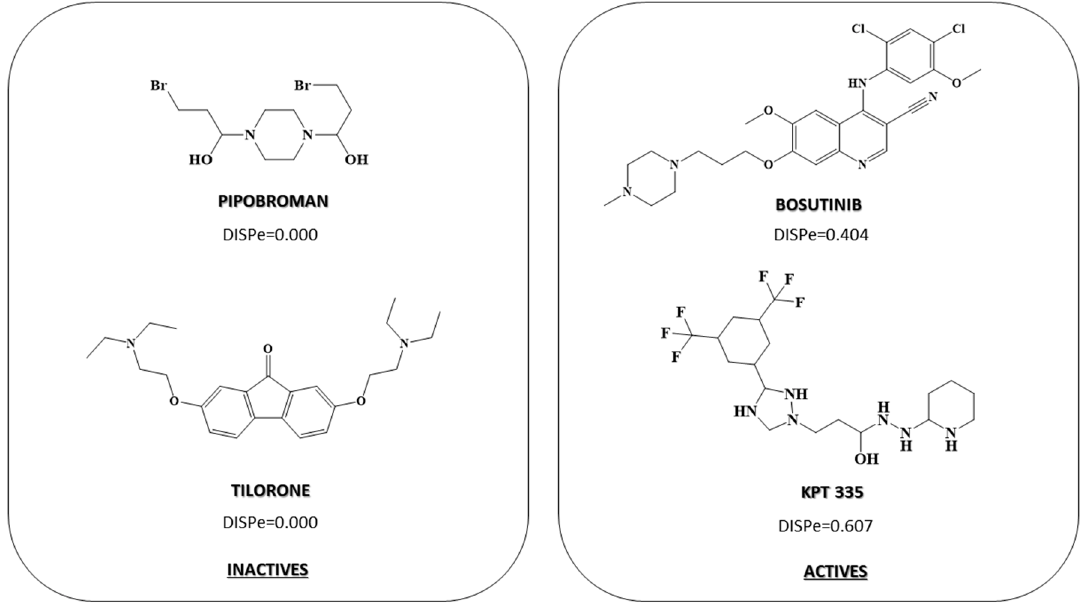
Figure 3. Most relevant descriptors in determining the chemical–mathematical pattern related to anti-TDP-43 activity for DF TDP43 . anti-TDP-43 activity for DF TDP43